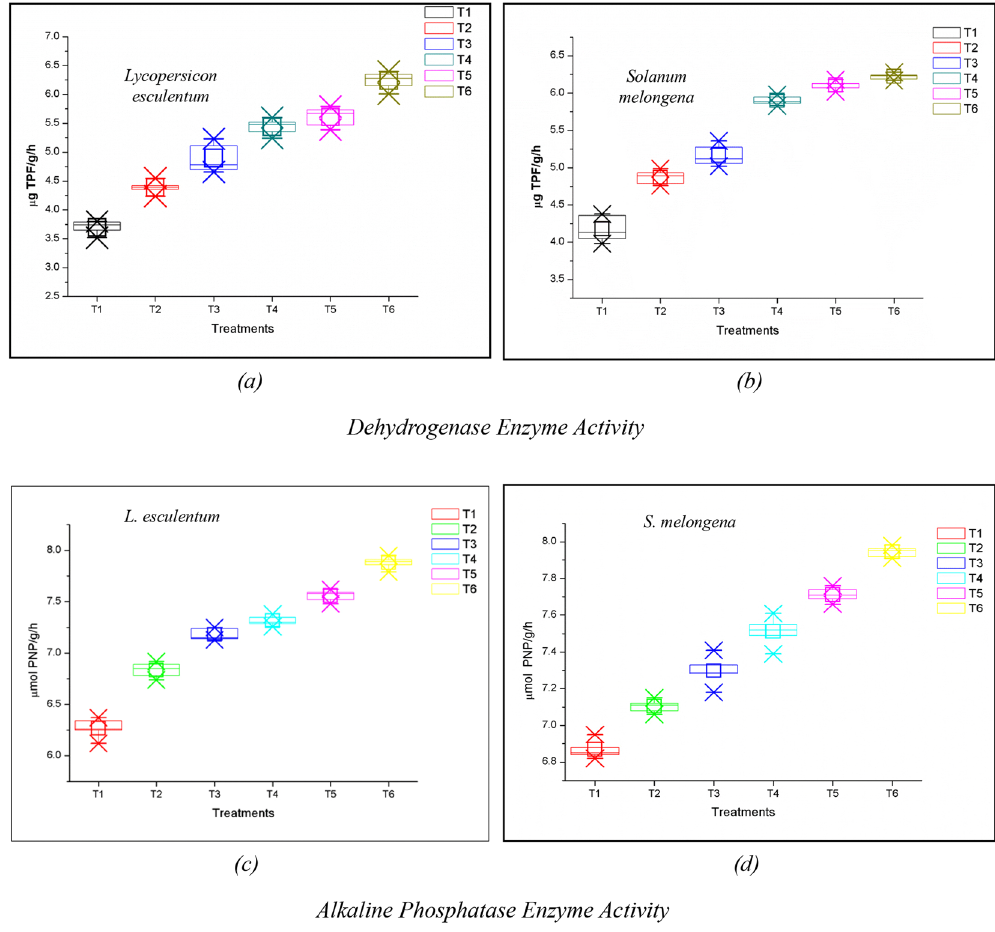
Figure 2. Variations in the dehydrogenase enzyme and alkaline phosphatase enzyme activity of treatments at the time of harvesting of Lycopersicon esculentum and Solanum melongena